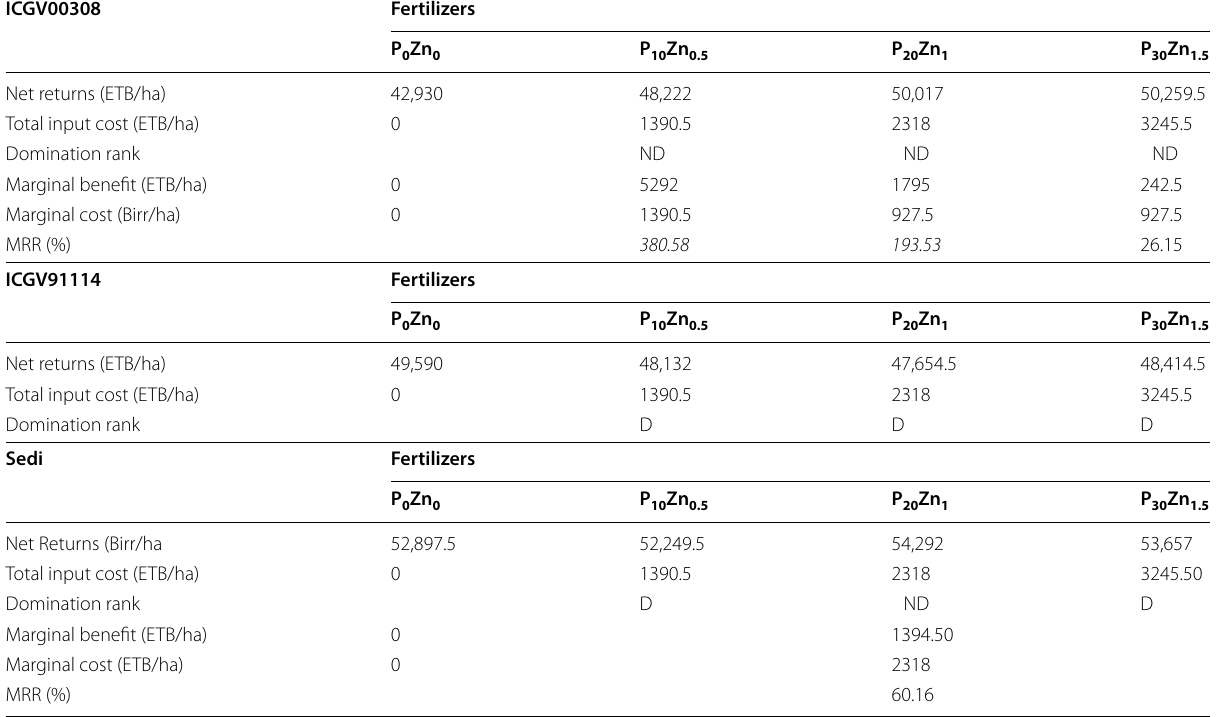
The value written by italic indicated the highest MRR% D dominated treatment; ND =